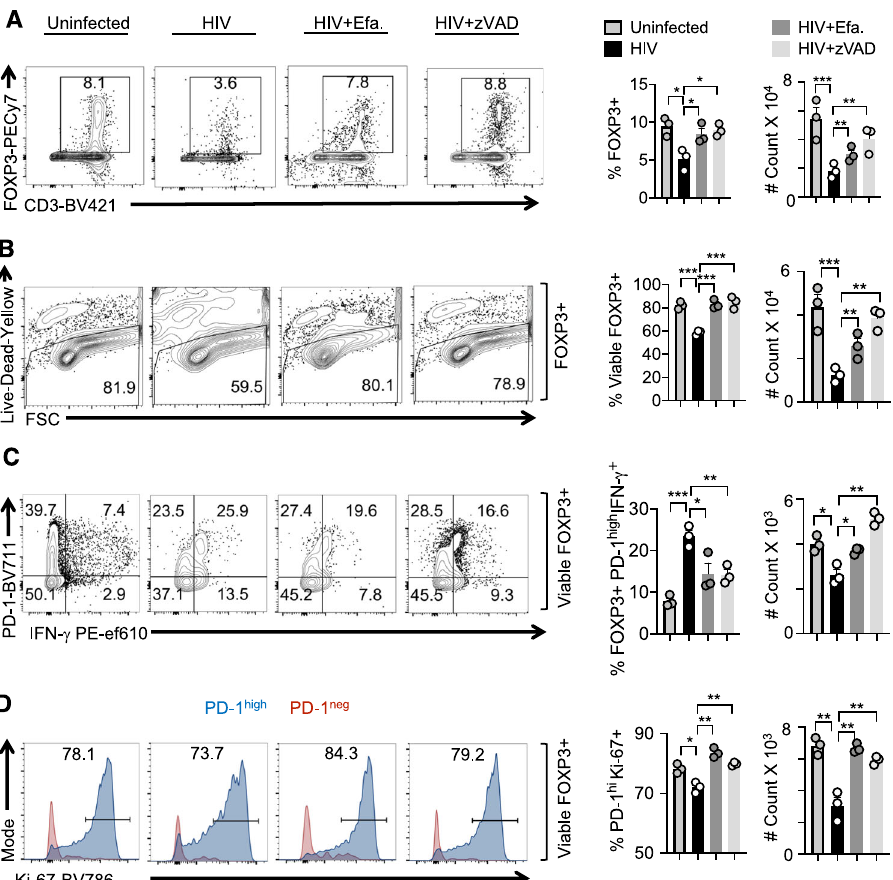
Fig. 4 Blocking subsequent rounds of infection and cell death increased the proliferation of PD-1 hi IFN- γ + FOXP3 + cells. Whole HTC was activated with TCR stimulation, infected with HIV, and allowed to expand in the presence of TGF- β 1 (10 ng/ml) and IL-2 (100 U/ml) for 6 days. Viral inhibitor Efavirenz (50 nM) or cell death/pan-caspase inhibitor z-VAD (10 μ M) was added 28 h post-infection as described in “ Methods. ” Flow cytometry acquisition was done with constant time for all the samples. Percentage of CD3 + FOXP3 + cells pre-gated on CD8 − cells ( A ), viability of FOXP3 + cells pre-gated on CD3 + CD8 − cells ( B ), PD-1 and IFN- γ expression in viable CD3 + CD8 − FOXP3 + cells ( C ), Ki-67 expression in viable PD-1 high and PD-1 low FOXP3 + populations ( D ) are shown. A – D Representative contour plots (left), statistical analyses of proportions of the cells (middle), and statistical analyses of the absolute cell counts (right) are shown (ordinary one-way ANOVA alpha = 0.05* and multiple comparison t tests; * P < 0.05; **<0.005, ***<0.0005). Results are derived from three independent experiments ( n = 3) and are presented as mean value + / −